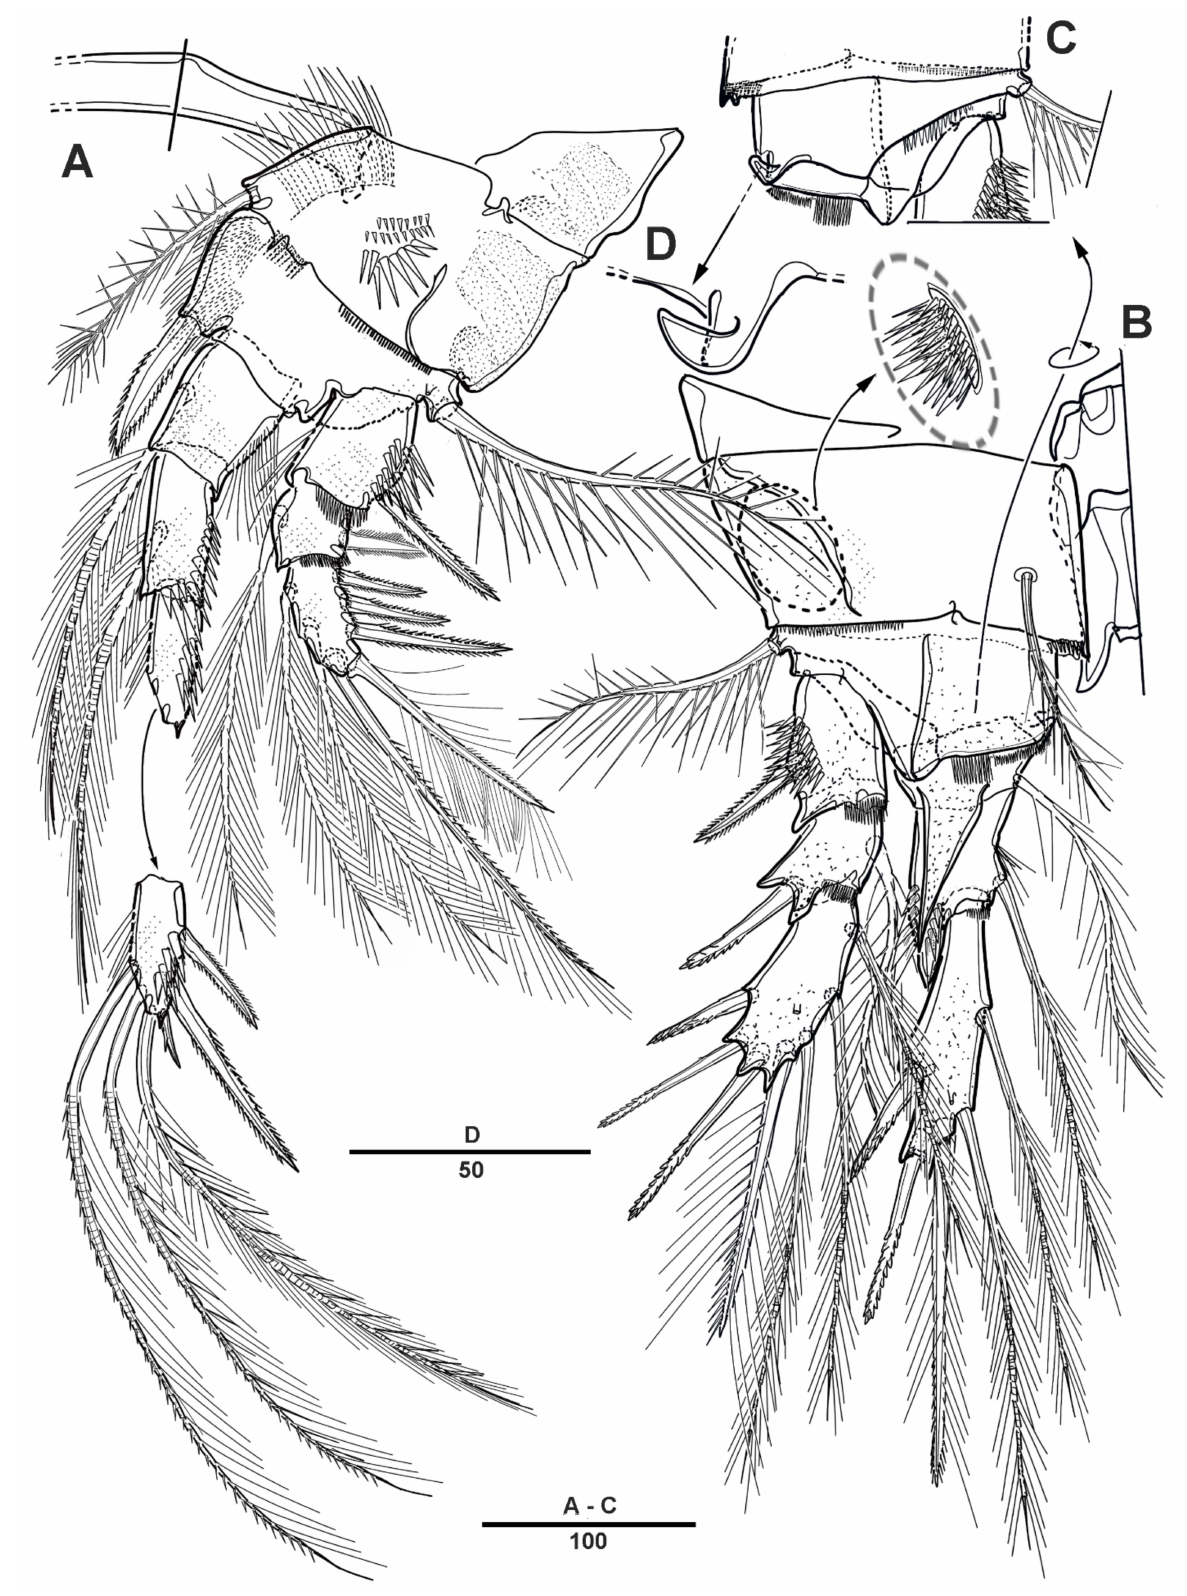
Figure 6. Scottolana daecheonensis sp. nov. holotype female: ( A ) P1, anterior; ( B ) P2, anterior (inset showing dense patch of strong spinules); ( C ) P2 basis, posterior; ( D ) P2, basal inner process. Scale bars in µ